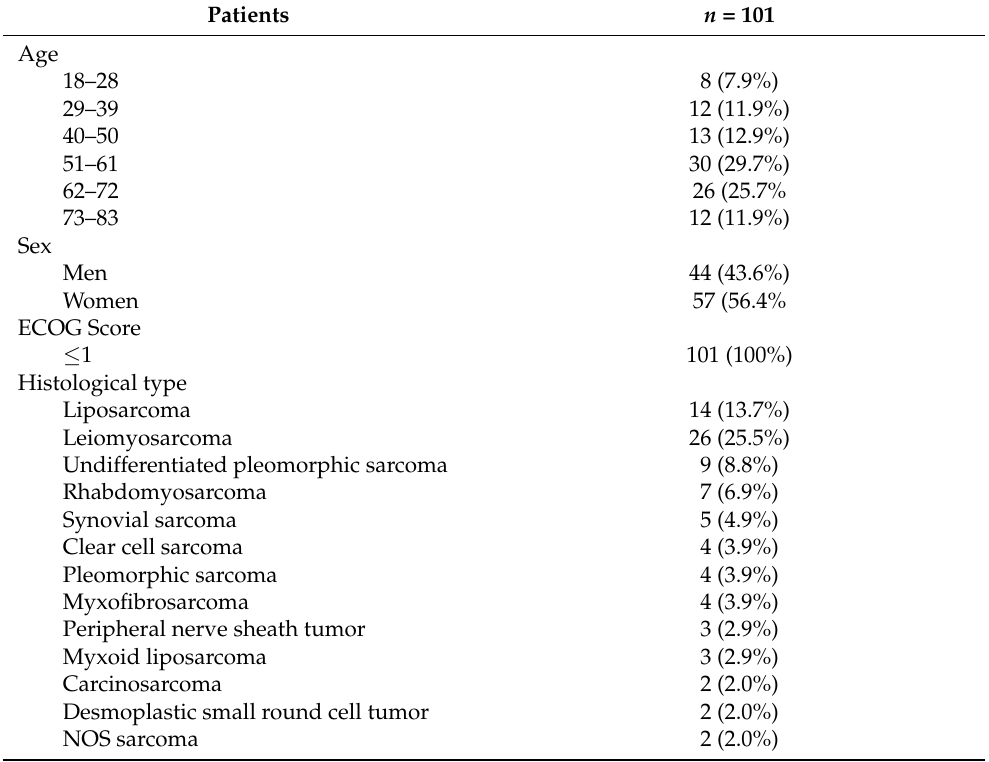
Table 1. Baseline